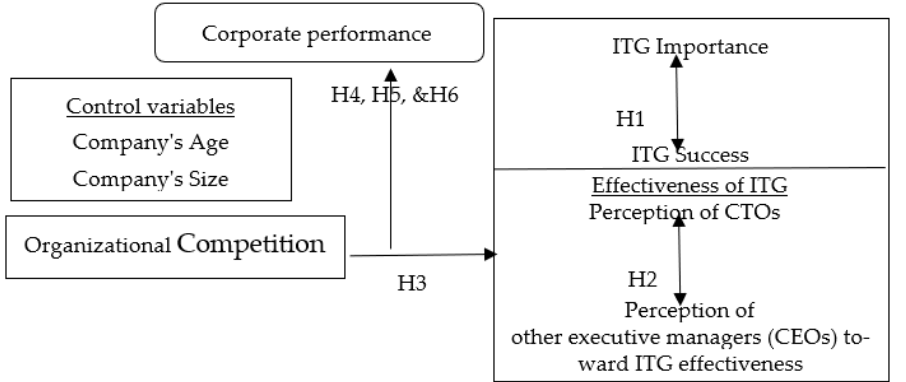
Figure 1. Theoretical model of the study.